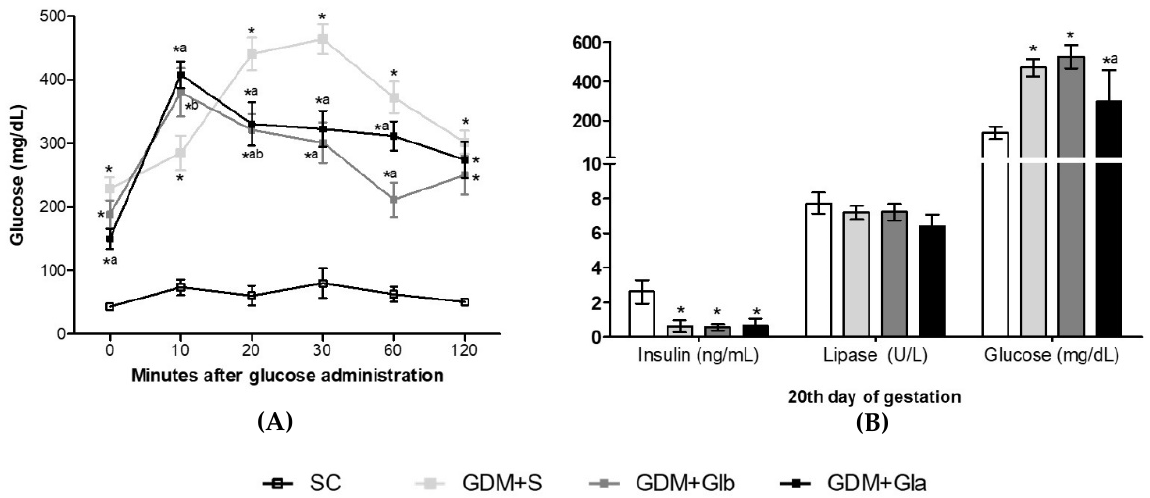
Figure 1. ( A , B ) The evolution of GDM-STZ. SC (0.9% saline solution), GDM+S (Diabetic + saline solution 0.9%), GDM+Glb (Diabetic + 100 mg/kg/day of Ganoderma lucidum from gestation day 1 to 19), GDM+Gla (Diabetic + 100 mg/kg/day of Ganoderma lucidum from gestation day 9 to 19). Data are presented as mean ± SD ( n = 6). (*) p < 0.05 in comparison to the SC group, (a) in comparison to the GDM+S group, (b) in comparison to the GDM+Glb group; One-way ANOVA, followed by Tukey–Kramer’s